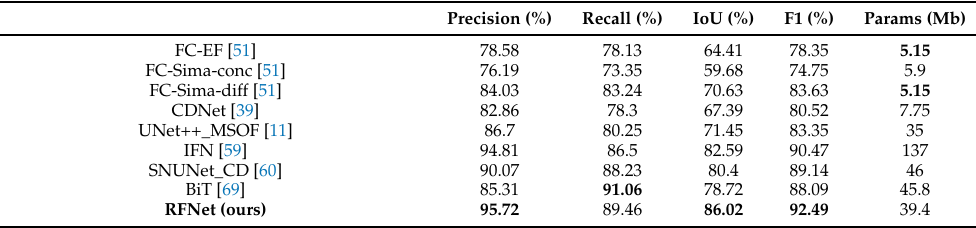
Table 5. Model comparison of the WHU dataset. The values in bold font are the best.